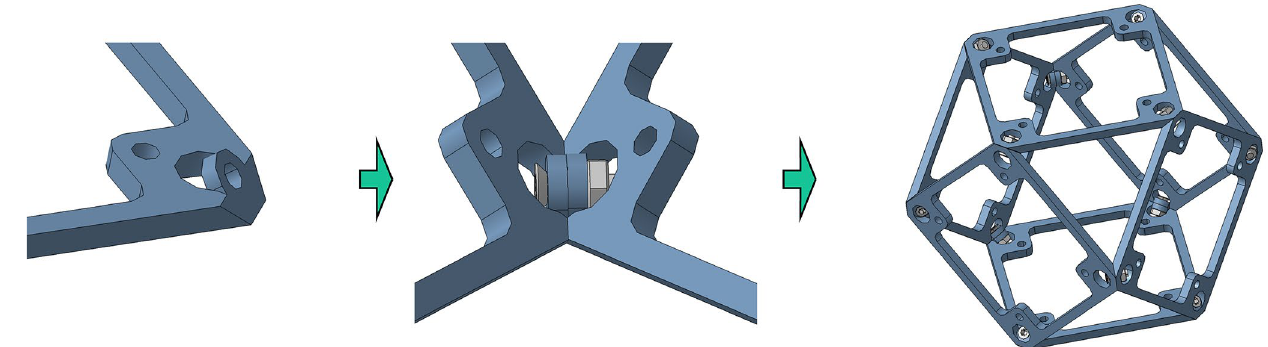
Figure 18. Schematic diagram of a screw connection within a single cell.